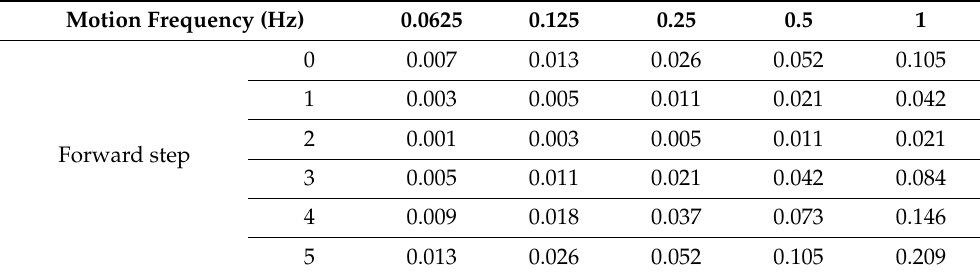
Table 4. Amplitude deviation with different numbers of prediction steps ( ω s = 100 Hz).